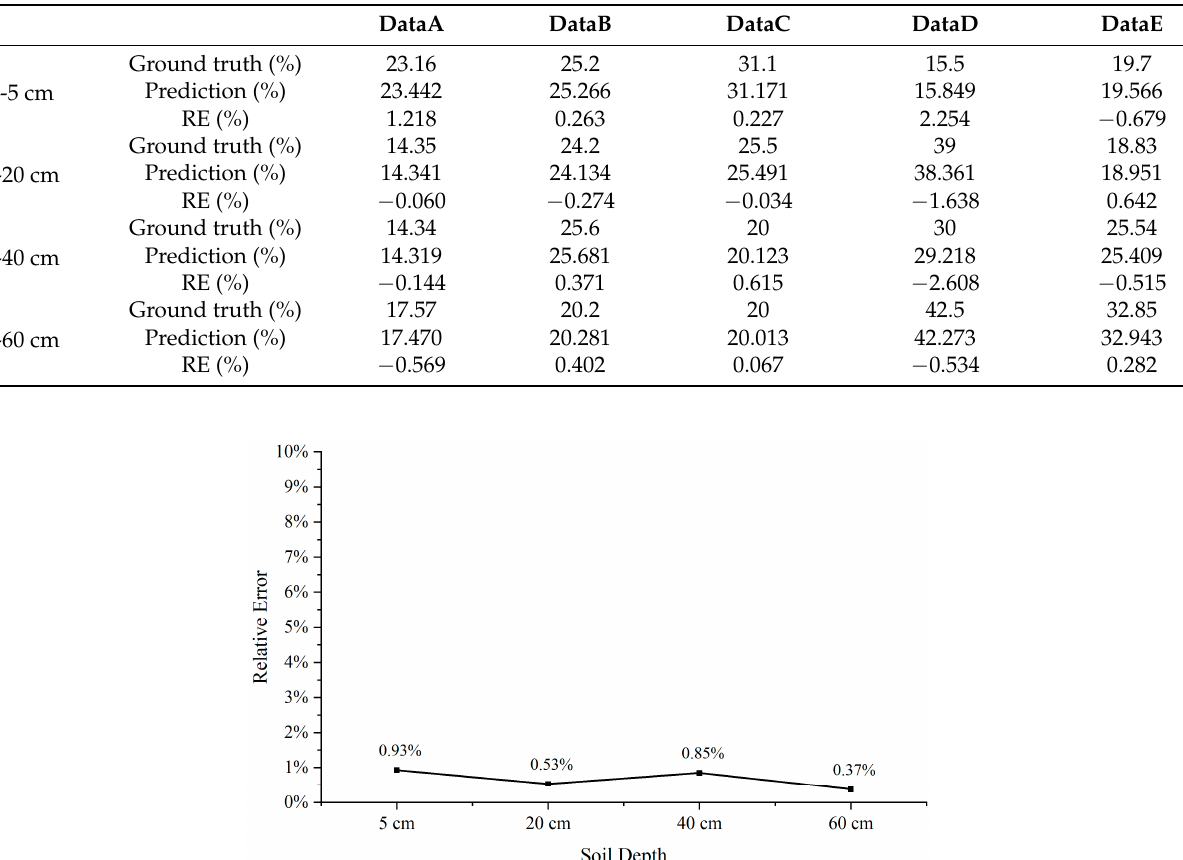
Table 11. Prediction results of DataA~DataE at different depths.